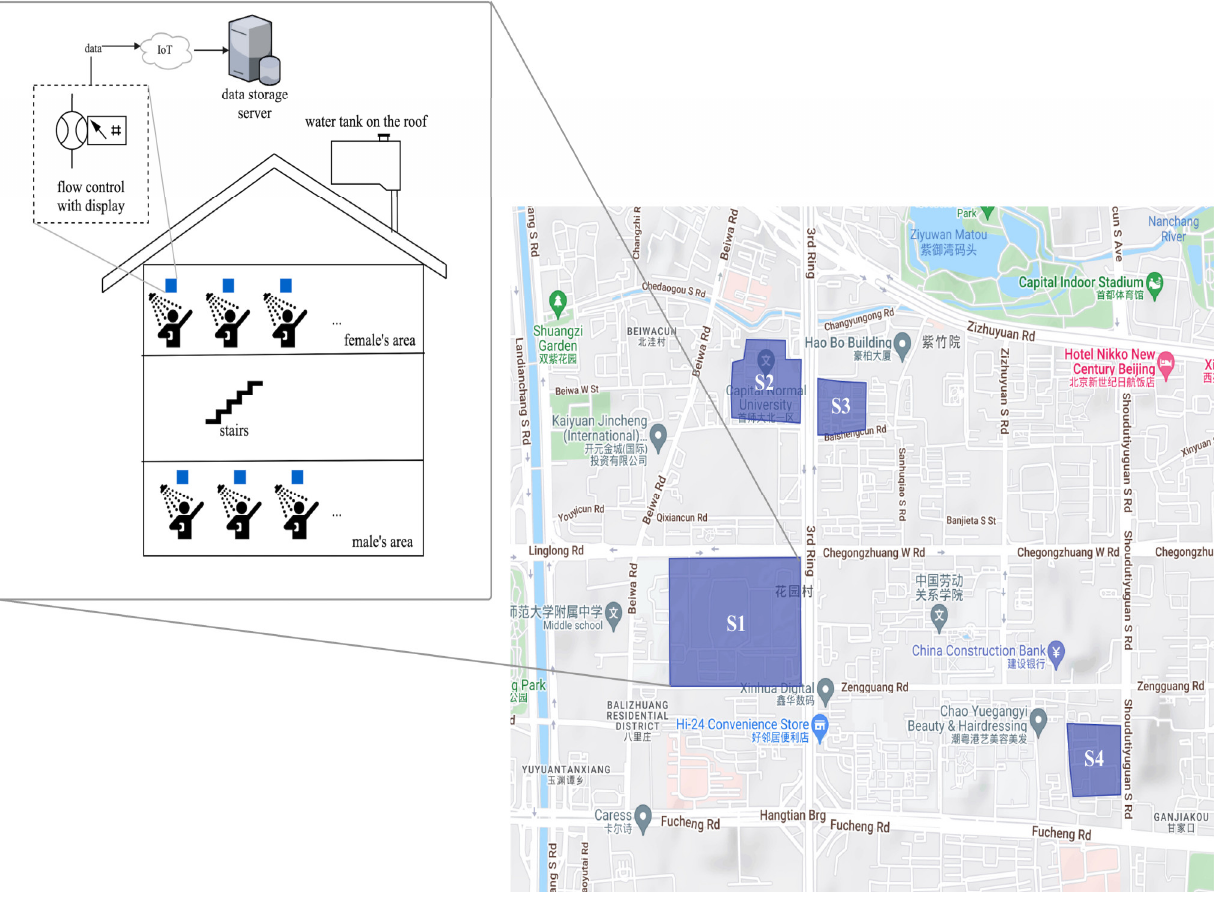
Figure 2. Distribution and architecture of shower buildings: S1 serves the largest area while S3 serves the smallest area in the campus.